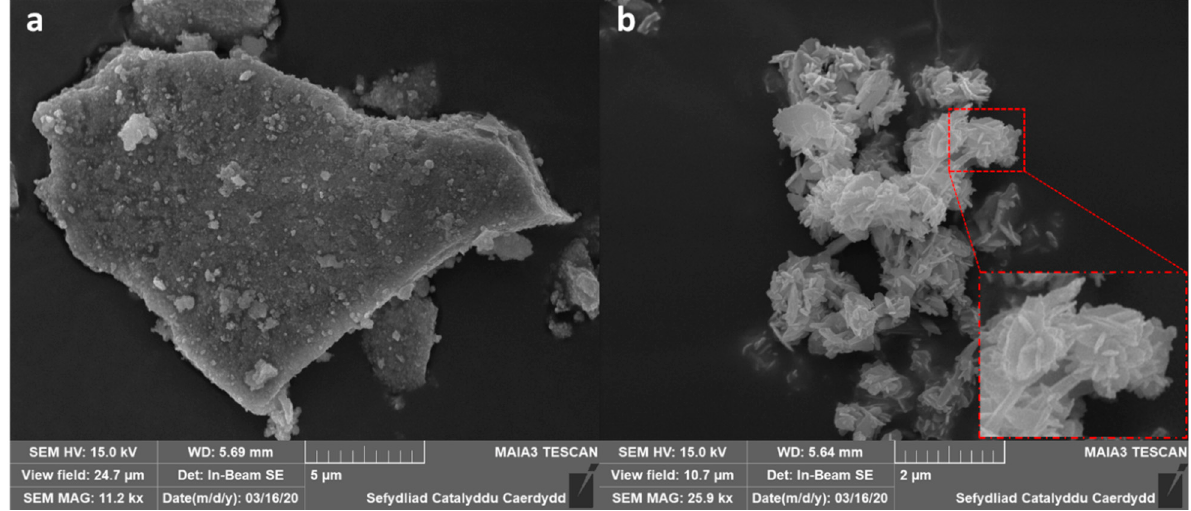
Figure 4. Scanning electron microscopy images of ( a ) CeO 2 (IV) and ( b ) CeO 2 (III) catalysts. Inset shows platelet type morphology.